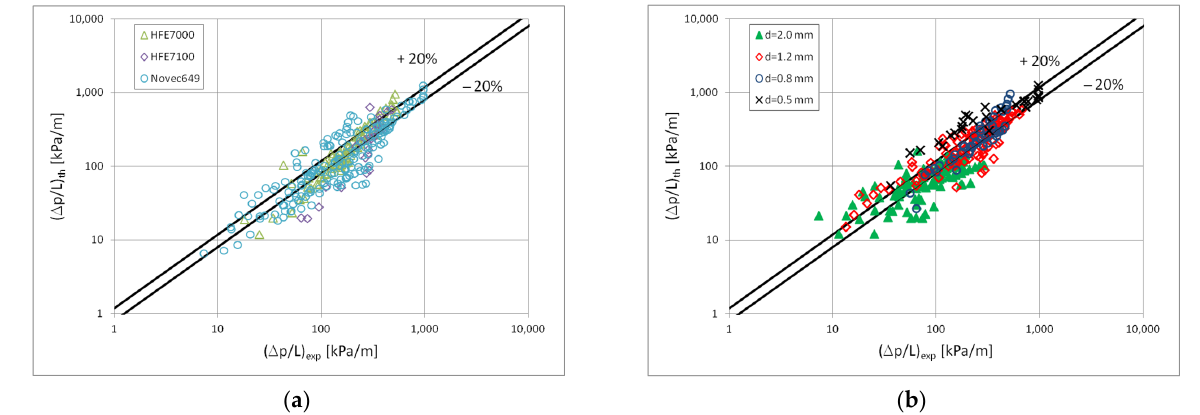
Figure 13. Comparison of the results of experimental studies on the condensation of the investigated refrigerants in mini-channels in terms of pressure drops with the proprietary correlation (3) for the dispersion structure; ( a ) for individual refrigerant, ( b ) for individual mini-channels diameters.